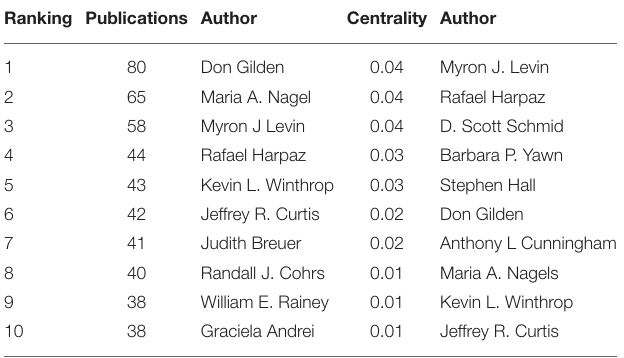
TABLE 4 | Top 10 co-cited authors in herpes zoster research in terms of co-citation counts and